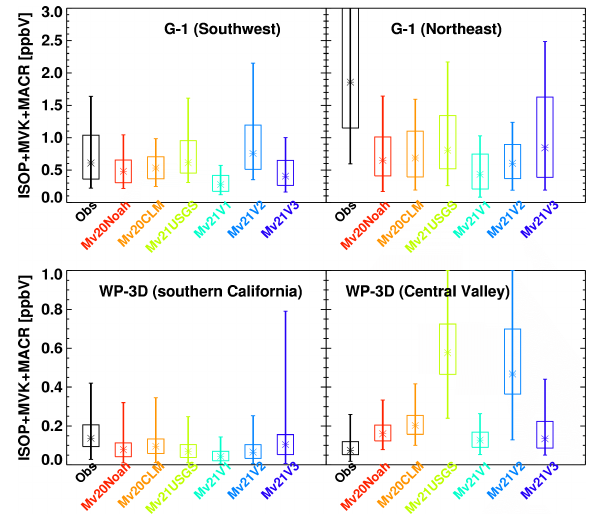
Figure 16. Comparison of isoprene + MVK + MACR mixing ratios averaged below 1km from the observations by G-1 flights over the southwest and northeast regions (as marked in Fig. 12a) and WP-3D flights over southern California and the Central Valley (as marked in Fig. 12b) and the corresponding simulations. Asterisk denotes the 50th percentiles. Vertical lines denote 10th and 90th percentiles and the boxes denote the 25th and 75th percentiles.